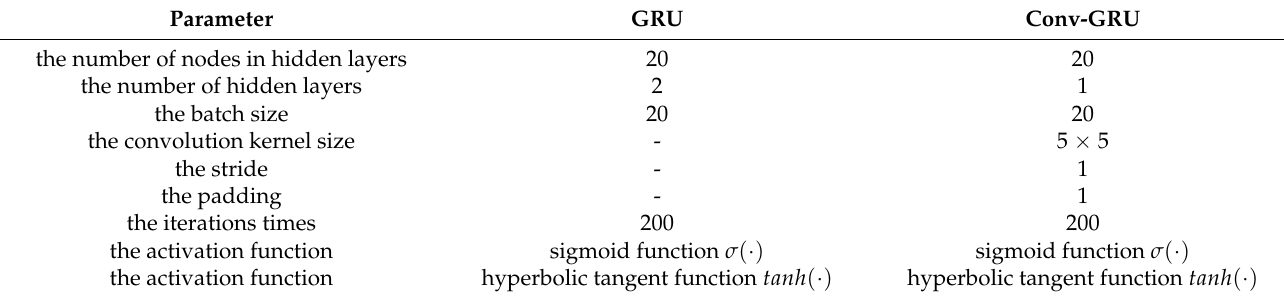
Table 2. Parameters of the Conv-GRU and GRU